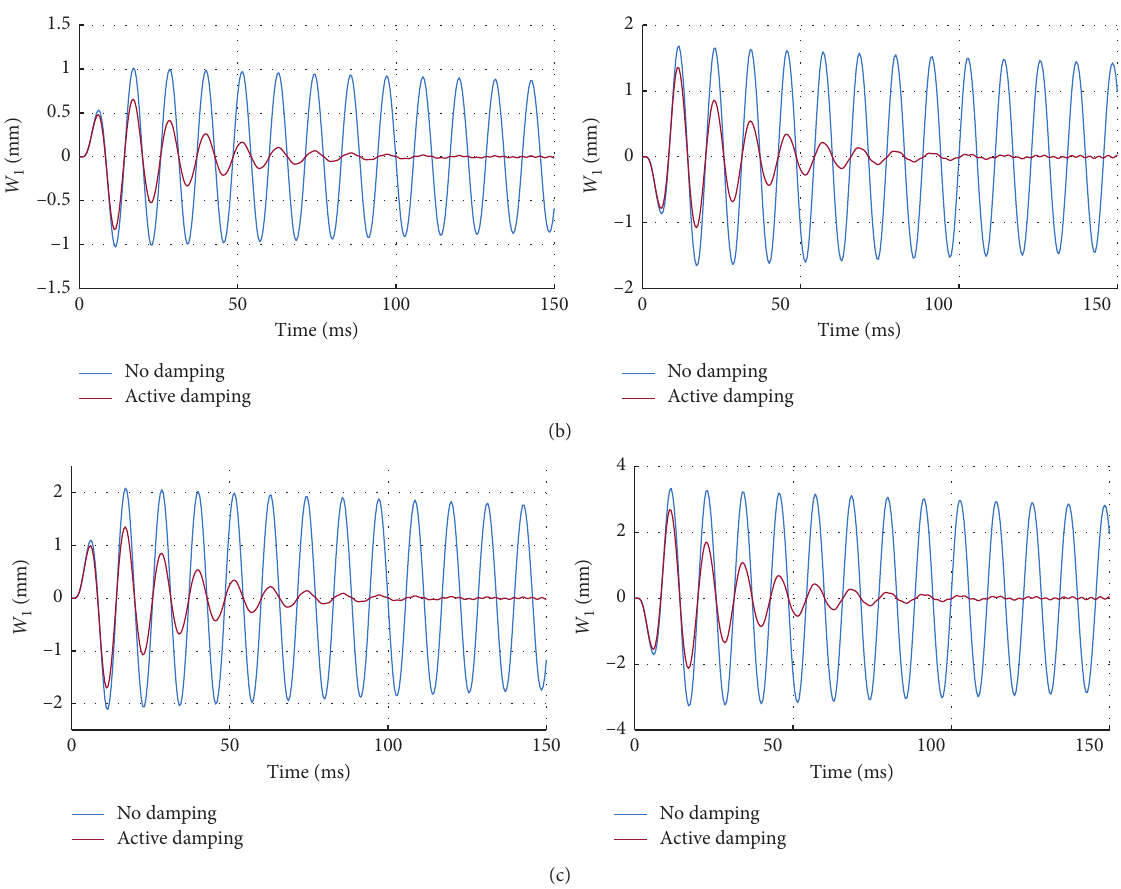
Figure 9: Flexible deformation of each links. (a) 1 st trajectory. (b) 2 nd trajectory. (c) 3 rd trajectory.